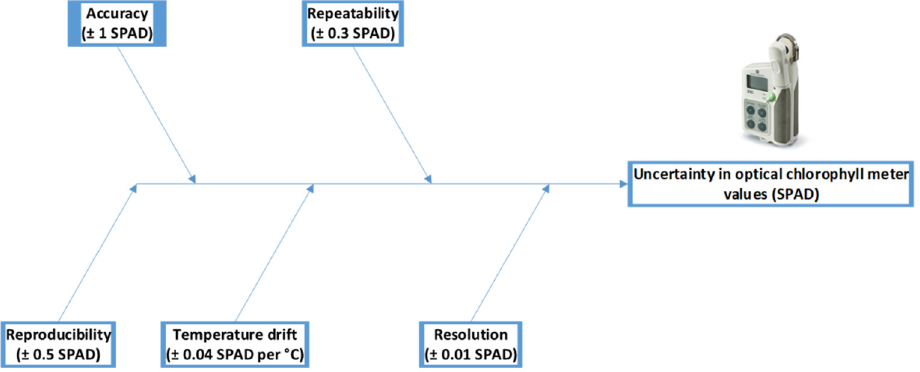
Figure 5. Uncertainty tree diagram illustrating the components contributing to uncertainty in SPAD-502 values [43].